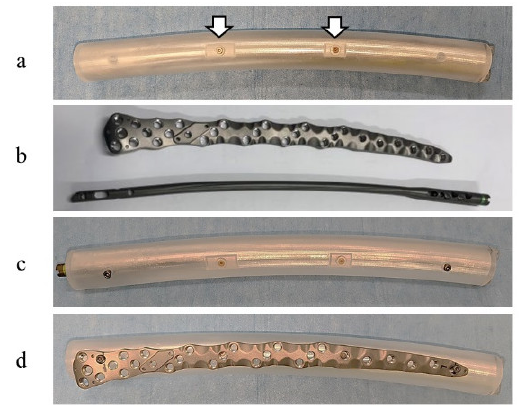
Figure 2. Photographs of the phantom and implants used in this study. ( a ) Two lesions (white arrows) were present in the phantom, and the structure was constructed such that an intramedullary nail could be installed in the center. ( b ) The implants at the top and bottom of this panel are the plate and intramedullary nail, respectively. ( c ) The installed intramedullary nail and ( d ) plate are shown.